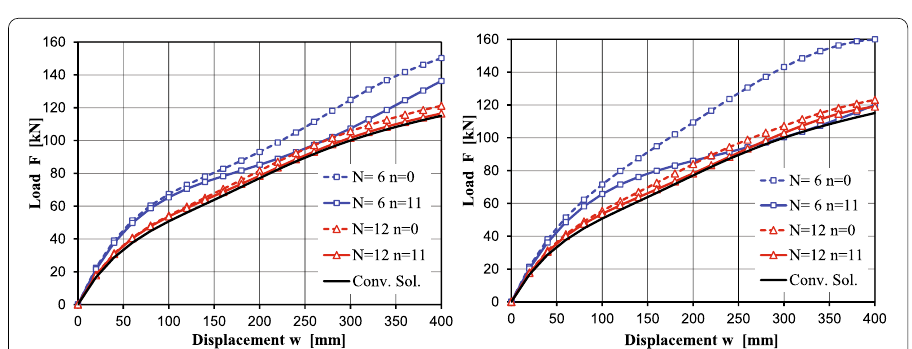
Fig. 39 Load deflection curves for different N and n as well as regular meshes (left) and distorted meshes (right)